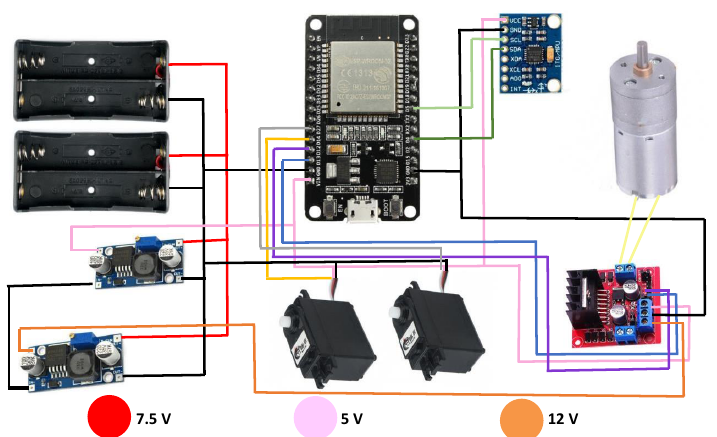
Figure 2. Electronic circuit used for the construction of the spherical robot.